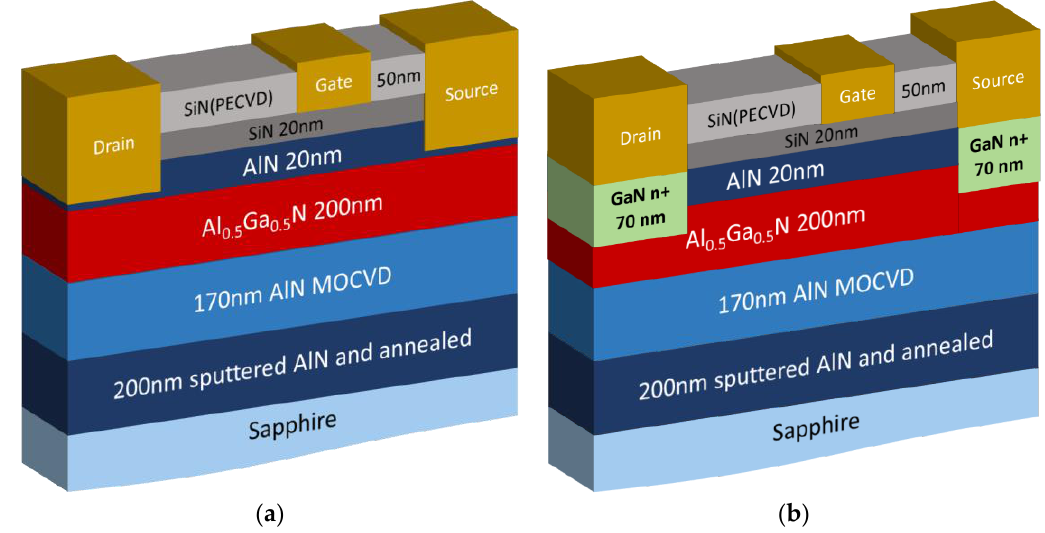
Figure 2. Schematic cross section of the AlN/AlGaN/AlN high-electron mobility transistors (HEMTs) with partially recessed annealed ohmic contacts ( a ) and non-alloyed regrown ohmic contacts ( b ).